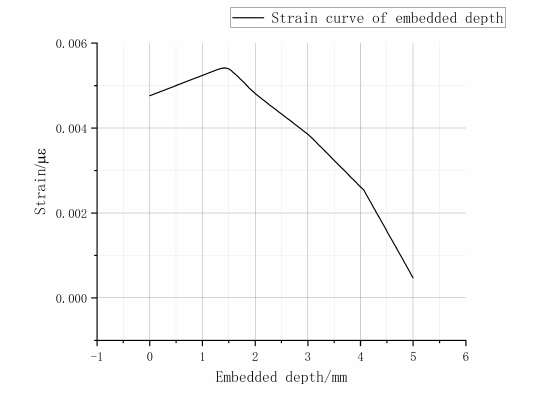
Figure 5. Strain values on the